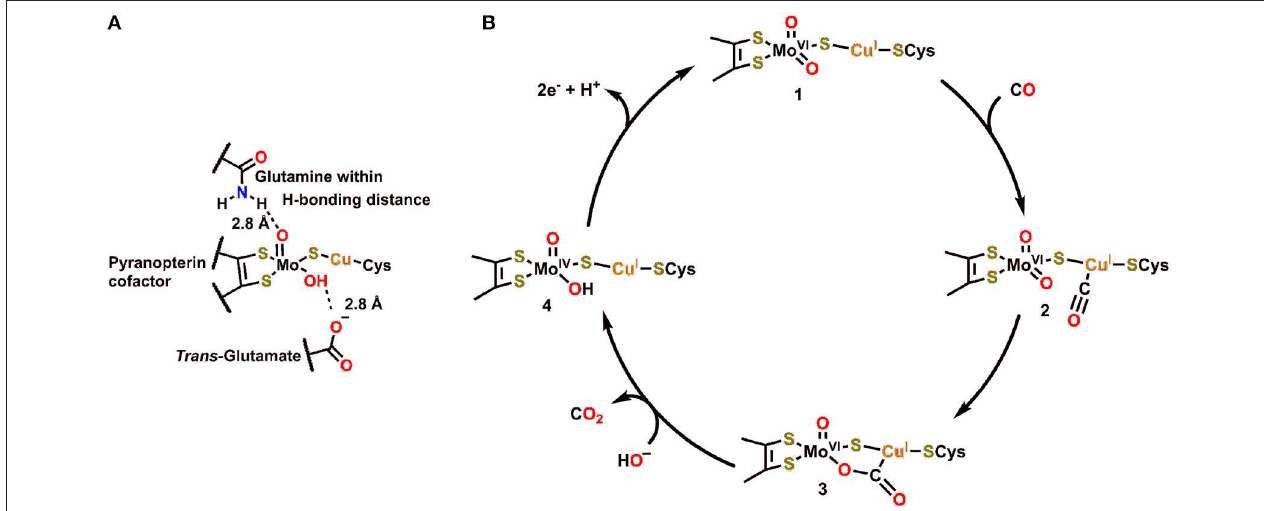
FIGURE 1 | (A) Active site of Cu,Mo-CODH. (B) Proposed catalytic cycle for oxidation of CO by Cu,Mo-CODH (Dobbek et al., 2002; Kroneck and Torres, 2014).